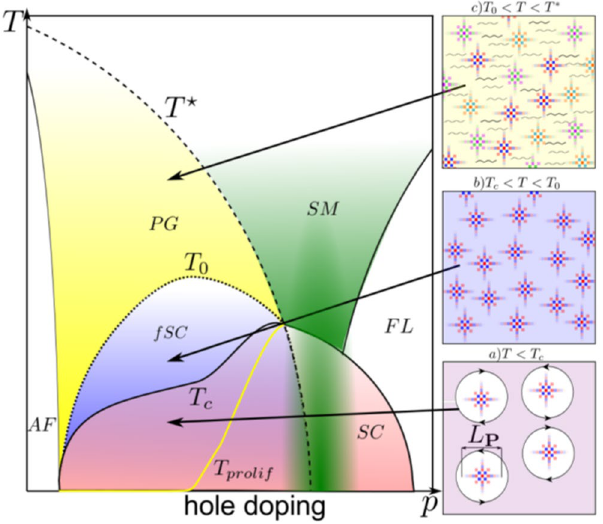
Figure 5. Schematic temperature-hole doping (T, P) phase diagram of cuprate superconductors. The strange metal phase is depicted in green and the Fermi liquid (FL) in white. Insets : ( a ) For T < T c , the particle-hole pair patches co-exist with superconductivity and are especially visible inside the vortex-antivortex pairs. L P is the typical size of a particle-hole pair patch. ( b ) For T c < T < T 0 , one observes the proliferation of patches and the superconducting fluctuations (fSC)- fluctuating up to a U(1) subset of the SU(2) symmetry- disappear at T 0 . ( c ) For T 0 < T < T * , the patches modulations are incoherent and electron scattering through the “particle-hole pair soup” leads to dissipation which accounts for the increase of the Fermi arcs with T . The temperature of proliferation of the patches T prolif is presented in